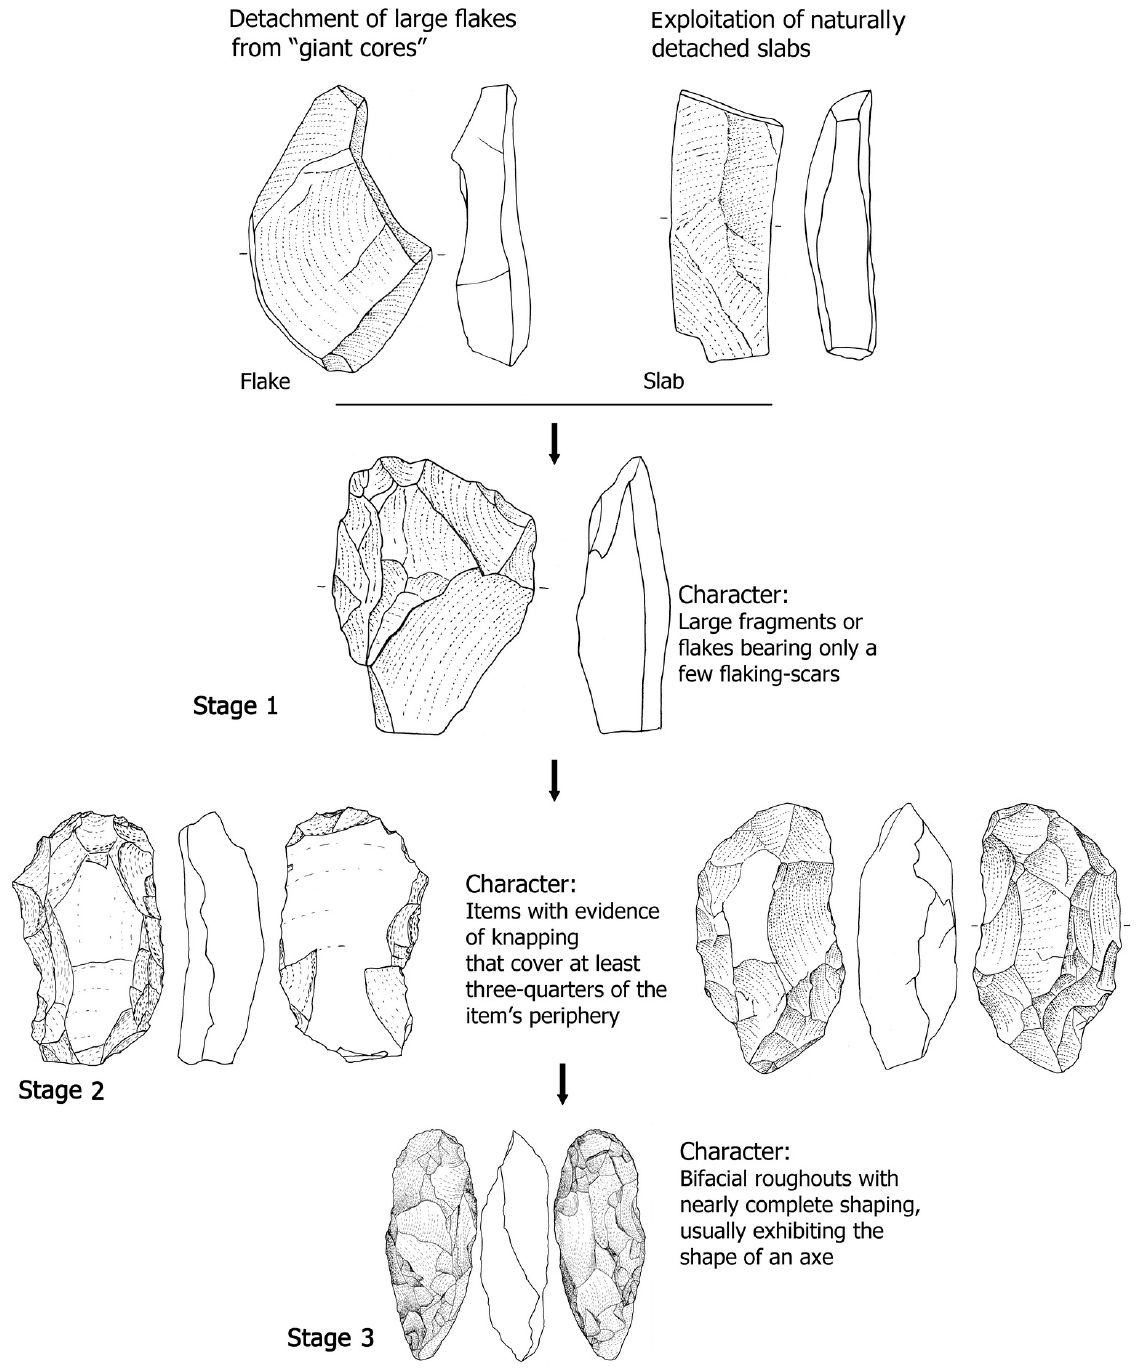
Figure 10. Stages of bifacial manufacture at the